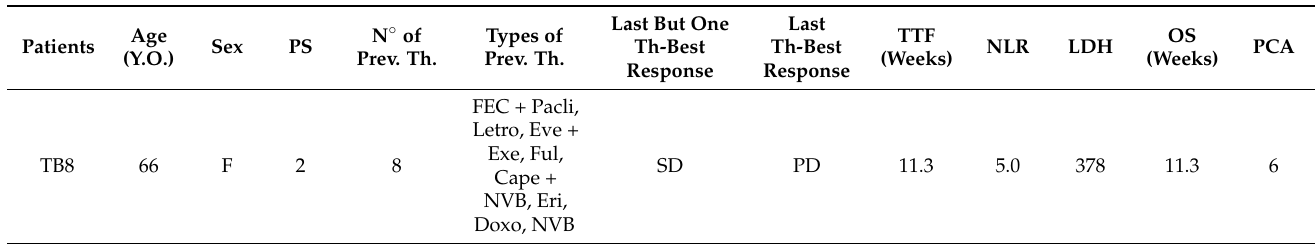
Table 2. Median Progression-free survival (PFS) and overall survival (OS) by the tumor primary site. mPFS, median PFS; mOS, median OS; CI, confidence interval; B, breast cancer; P, prostate cancer; K, renal cell carcinoma; C, colon cancer. mPFS (CI) Group